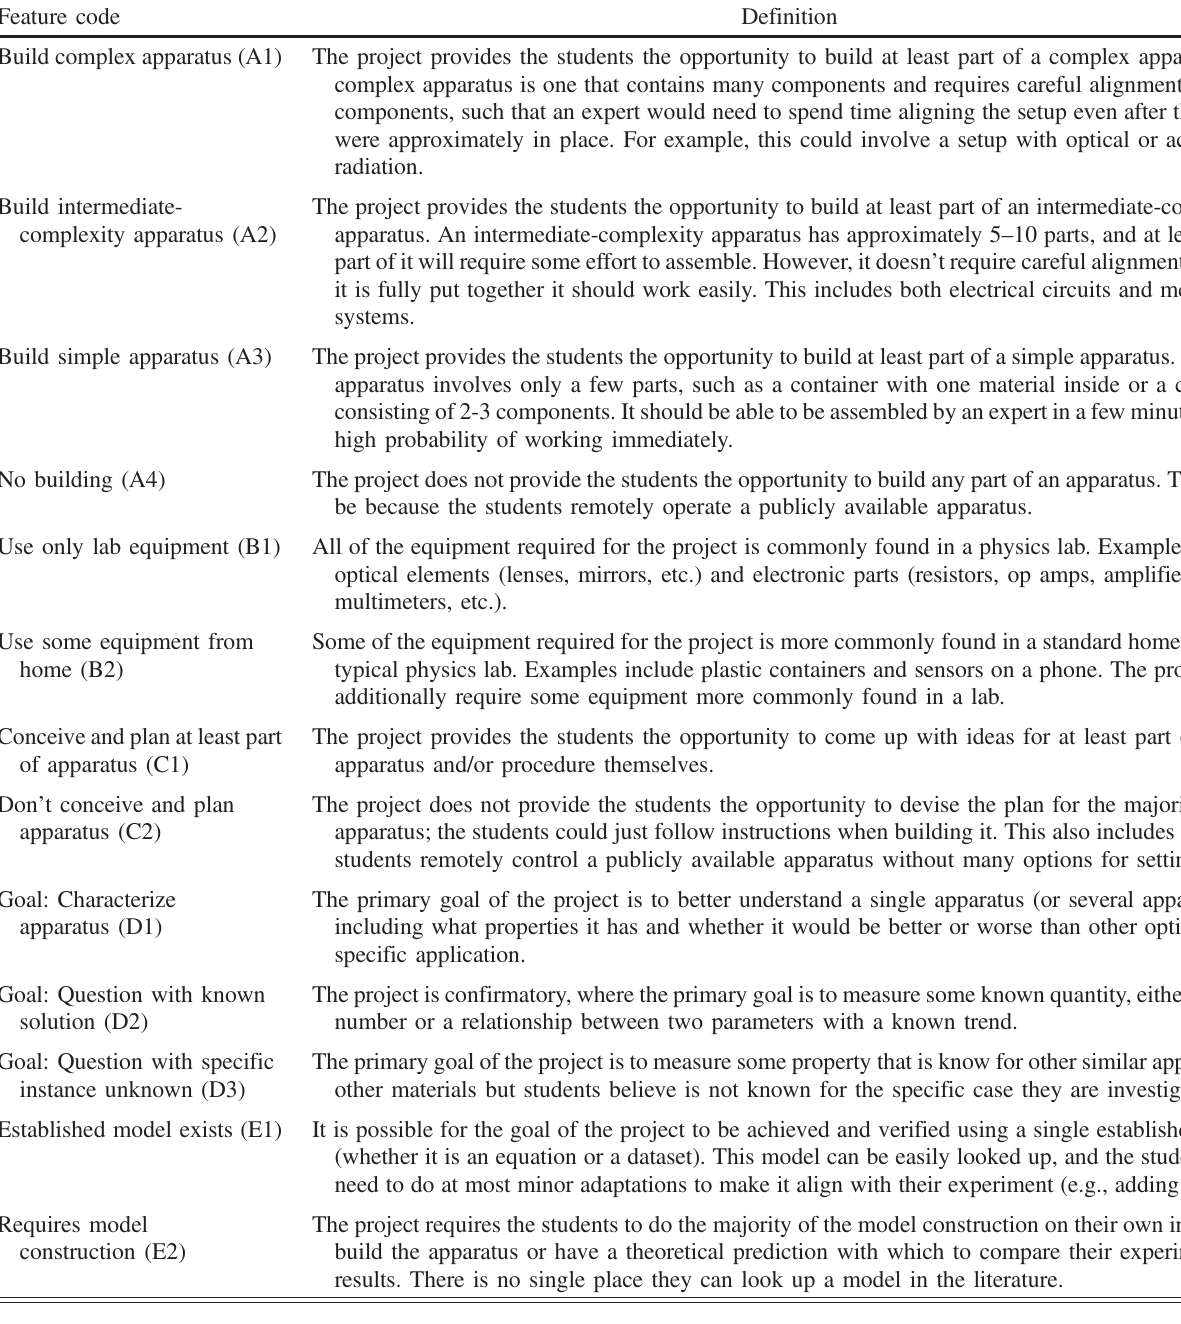
TABLE V. Project feature codes and their